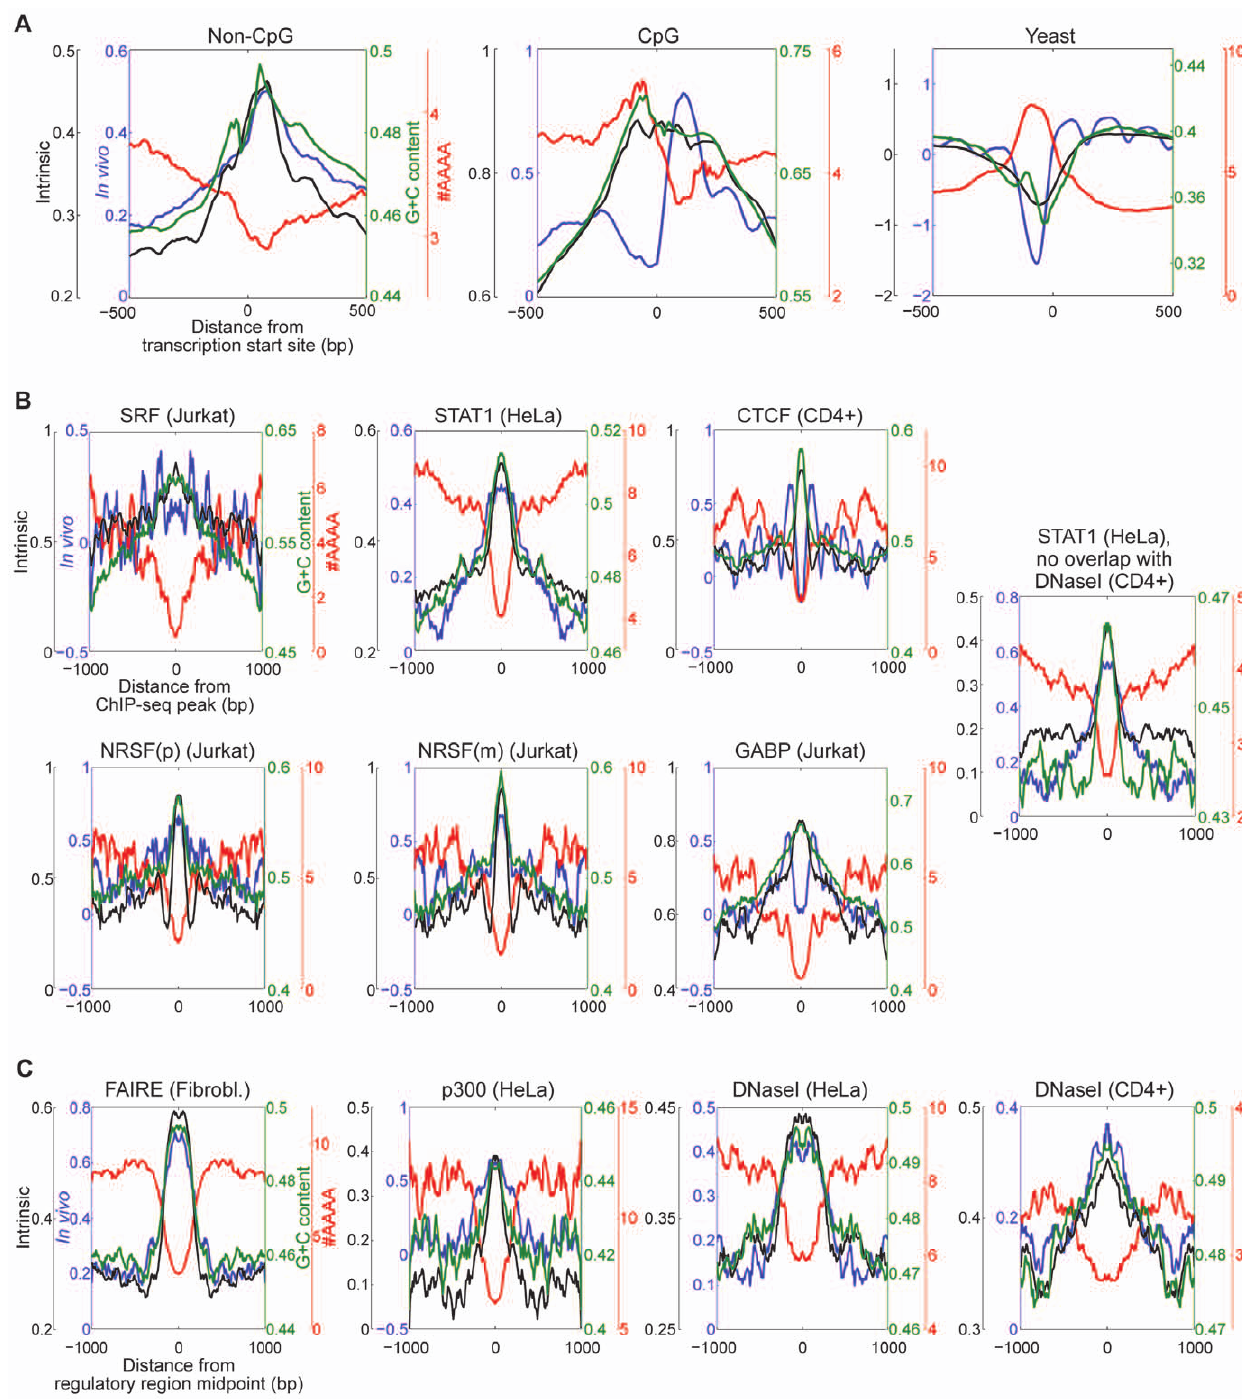
Figure 2. Average profiles of intrinsic nucleosome occupancy, invivo nucleosome occupancy, G + C content and frequency of poly-A (AAAA) sequences in human and yeast promoters, TF binding sites and putative non-promoter regulatory regions. ( A ) Average profiles of 20,286 non-CpG promoters, 11,757 CpG promoters, and 5,015 yeast promoters. ( B ) Experimentally determined transcription factor binding sites. ( C ) Putative regulatory regions. Sequences are defined by the studies indicated in the text and Methods. The average nucleosome occupancy at each base, relative to the center of the binding site or putative regulatory region, is from Schones et al. [8]. Proportion G + C and frequency of the 4- mer ‘‘AAAA’’ are calculated in 150 base windows. Note that vertical axes are different between different panels; they are adjusted to display the full range for each trace in each panel.